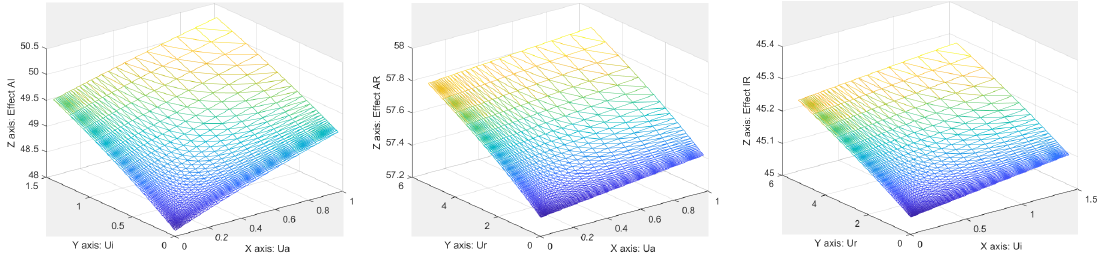
Figure A5. Surface responses obtained for γ = 1 for each drug combination.